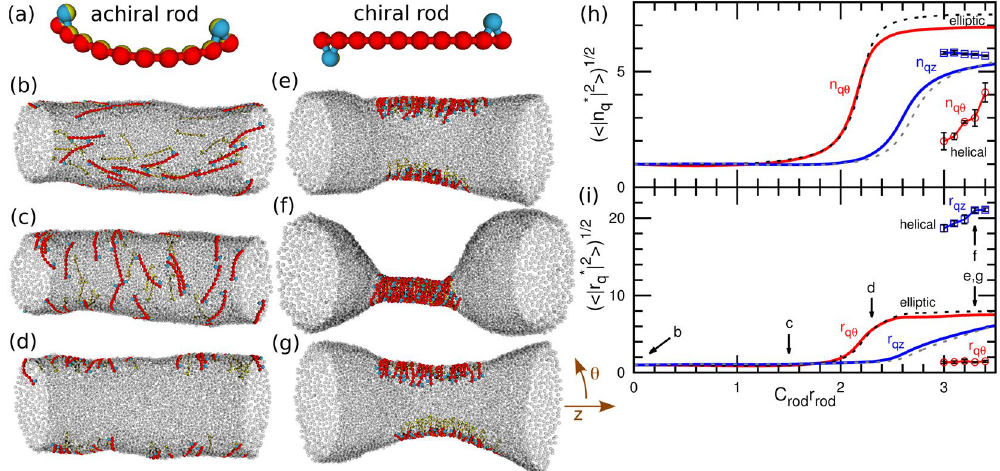
Figure 1. Membrane tube deformation induced by chiral and achiral protein rods without direct attraction between the rods at R cyl / r rod = 1.31 and N = 4800. ( a ) Protein models for achiral and chiral crescent-shaped rods. ( b – g ) Snapshots at ( b ) C rod r rod = 0, ( c ) 1.5, and ( d ) 2.3, and (e , f ) 3.3 for the chiral rods; and ( g ) C rod r rod = 3.3 for the achiral rods. The membrane particles are displayed as transparent gray spheres. ( h , i ) Fourier amplitudes of ( h ) rod densities and ( i ) membrane shapes. The solid and dashed lines represent the data for REMD of the chiral and achiral protein rods, respectively. The circles and squares with solid lines represent the q θ and qz modes, respectively, for the canonical simulations of the helical rod-assembly as shown in ( f ). The Fourier amplitudes are normalized by the values at C rod = 0 (denoted by the superscript * ). The error bars are displayed only for the canonical simulations. The errors in REMD are smaller than the thickness of the